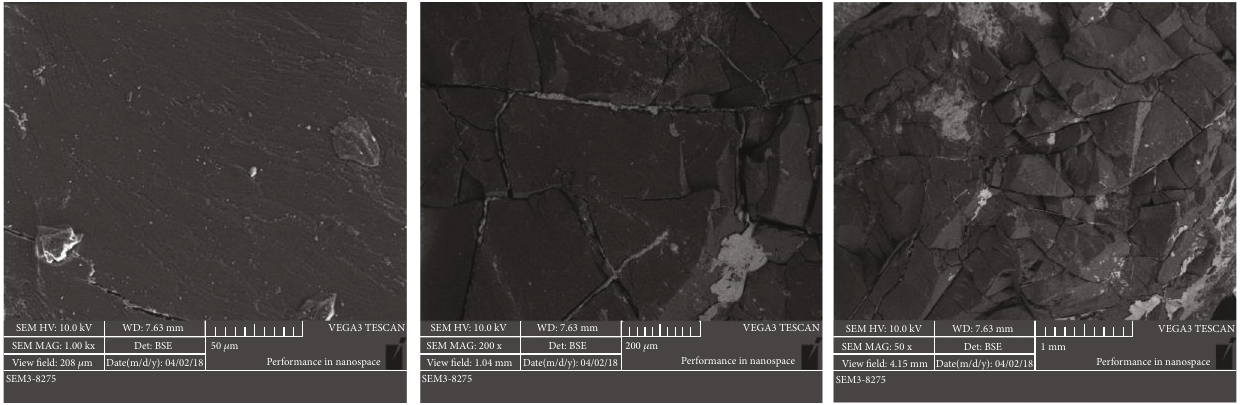
Figure 2: Microstructure of coal